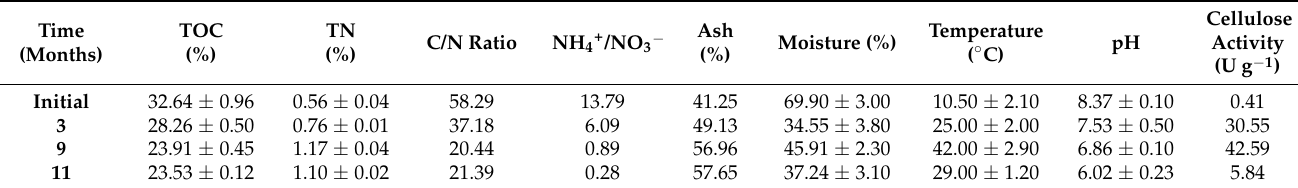
Table 2. Physical-Chemical properties changes throughout the composting